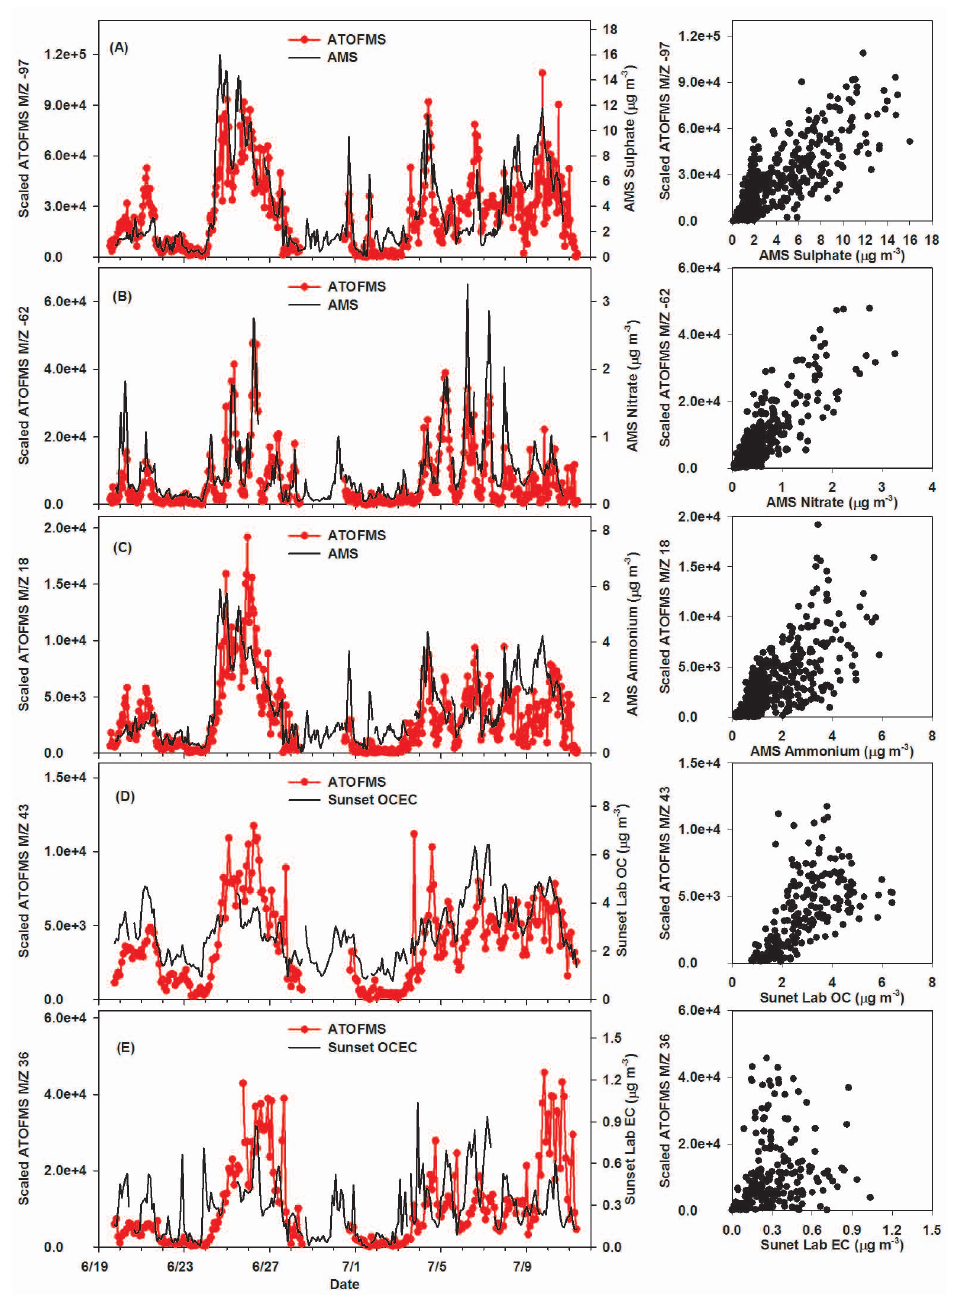
Fig. 5. Comparison between total ATOFMS relative peak area scaled by particle transmission efficiency and corresponding AMS mea- surements as well as Sunset Lab OC and EC concentrations during the BAQS-Met campaign in Harrow. (A) Sulphate, (B) nitrate, (C) ammonium, (D) OC, and (E)